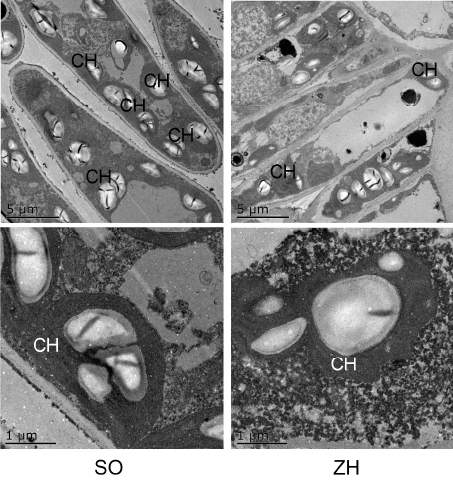
Figure 5. Observation of mesophyll cells of ‘SO’ and ‘ZH’. CH: chloroplast.